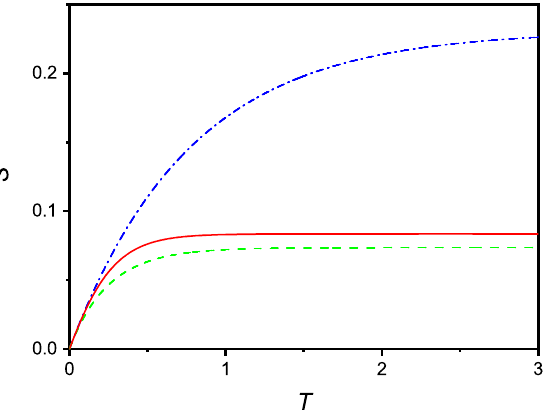
Figure 6. Comparison (in dimensionless units) of the time dependencies of S relevant to cases where saturation is absent (dash-dotted), with saturation linear in S (full) and saturation quadratic in S (dashed). The curves were drawn for u = 0.3 and r =